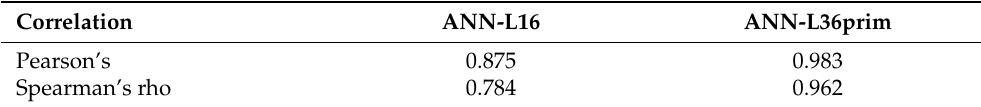
The huge values of the correlation coefficients (Pearson’s and Spearman’s rho) further show the consistency of the actual and estimated values obtained using the proposed models. In the ANN-L36prim architecture, the Pearson value is 0.983, which indicates an exceptional interrelationship between the observed values (Table 8). Table 8. Correlation coefficients (UCP).